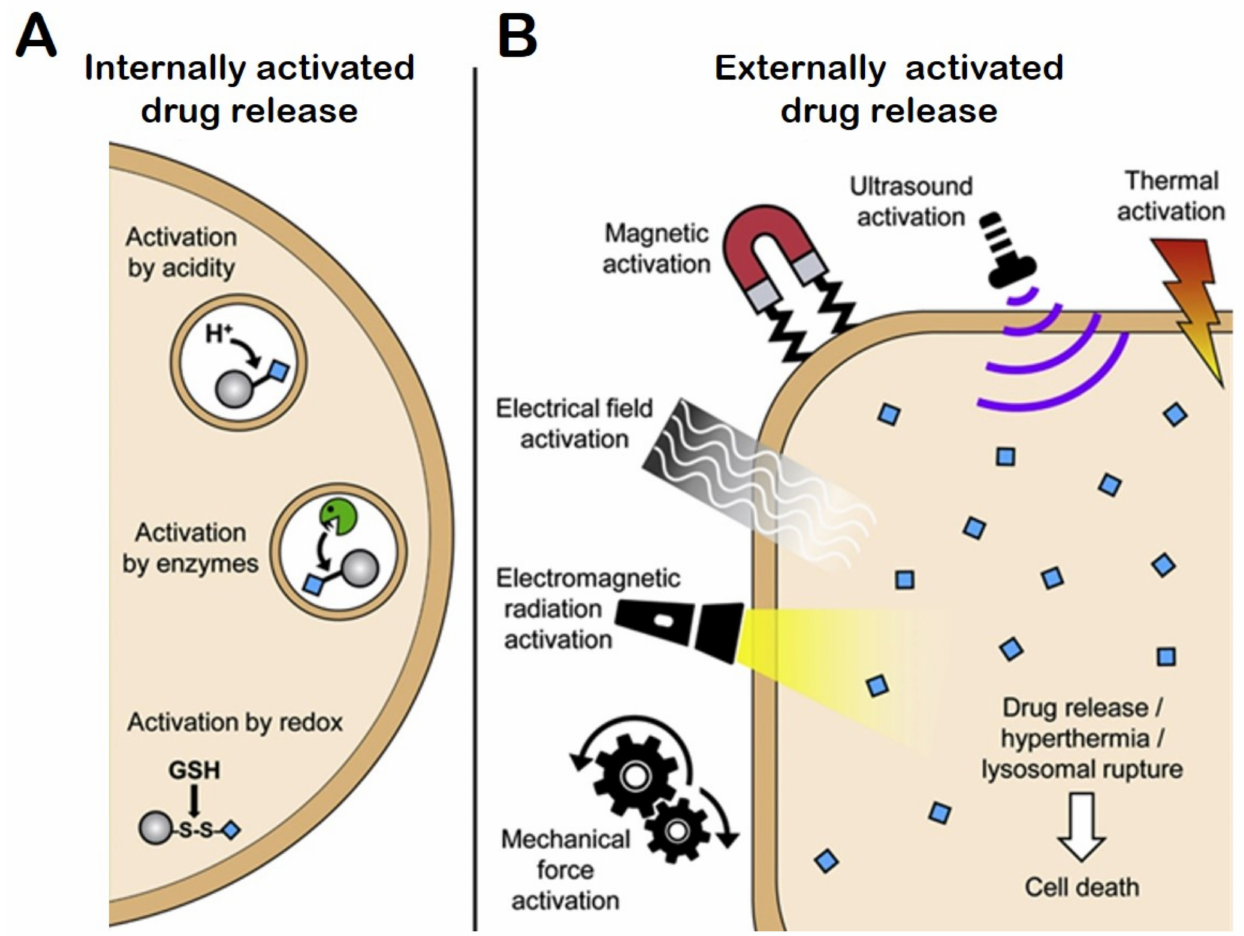
Figure 8. Drug triggering and release mechanisms of internally-activated ( A ) and externally-activated ( B ) drug release [25]. Stimuli sensitive drug release can be classified as internal-activated drug release and external activated drug release. Mechanisms including (i) activation of drug by change in pH, (ii) activation of drug by intracellular cancer enzymes, and (iii) redox-activated drug release are some of the prominent mechanisms for internal target-activated drug release. Some mechanisms most commonly used in research studies for external stimuli-responsive are (i) thermal activation, (ii) ultrasound activation, (iii) magnetic field activation (ultrasound mediated activation), (iv) electromagnetic radiation activation, and (v) magnetic force activation. These can aid or cause drug release of chemotherapeutic agents near the tumor site